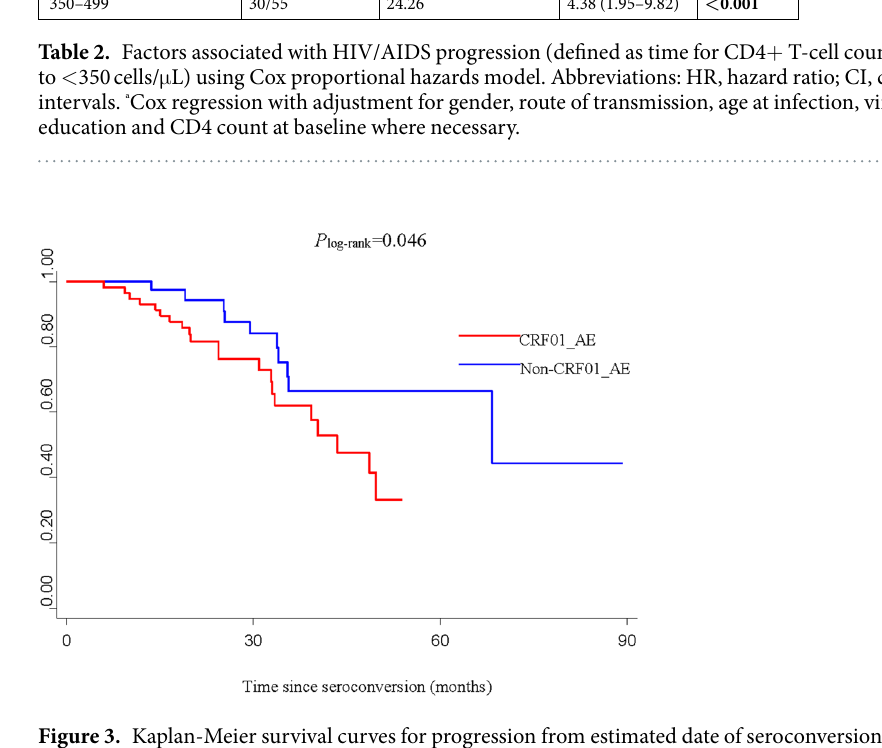
Figure 3. Kaplan-Meier survival curves for progression from estimated date of seroconversion to CD4 count < 350 cells/ μ L in different subtypes of male